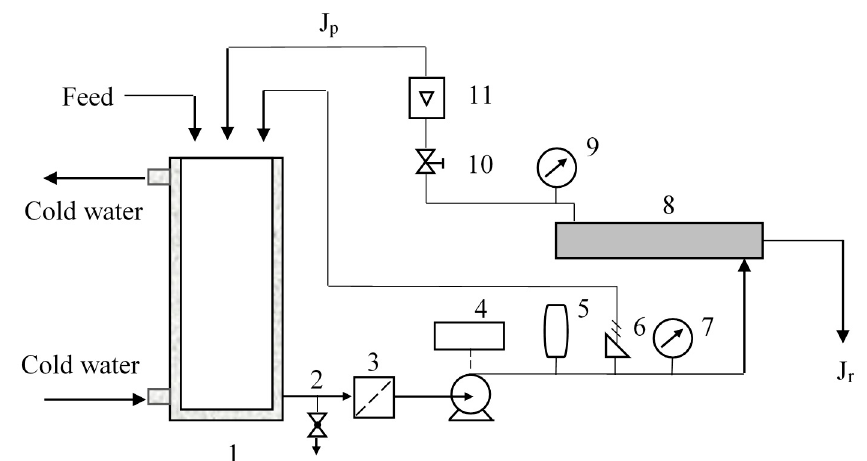
Figure 1. Experimental set-up of the nanofiltration separation. 1. Circulating tank; 2. Drain valve; 3. Pipeline filter; 4. Pump; 5. Frequency converter; 6. Safety relief valve; 7. Pressure gauge; 8. Membrane; 9. Pressure gauge; 10. Pressure regulating valve; 11. Concentrate flow meter.